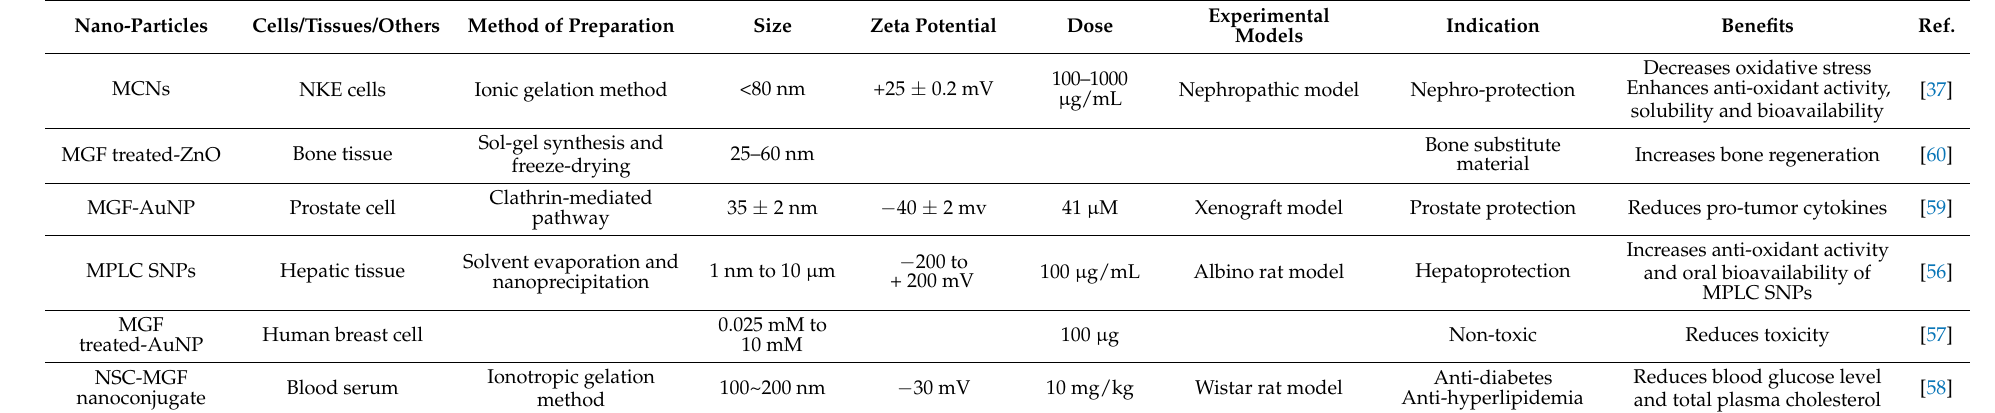
Table 3. Effect of nanoparticle based-mangiferin treatment on various pathological